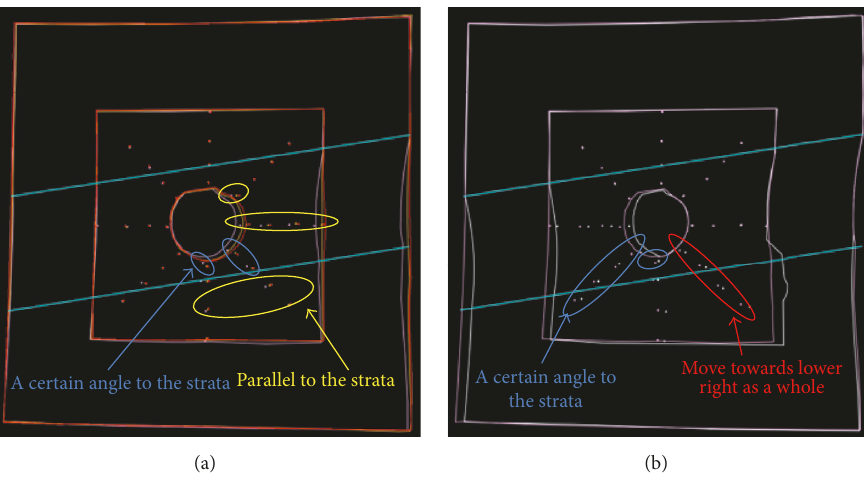
Figure 4: Stacking sketches of the images of Figure 3. The lithologic boundaries are drawn by light blue lines; (a) stacking diagram of the sketches of Figures 3(a), 3(d), and 3(e), which is sketched in red, orange, and pink, respectively; (b) the stacking diagram of the sketches of (e) and (f), which is sketched in pink and white line, respectively.